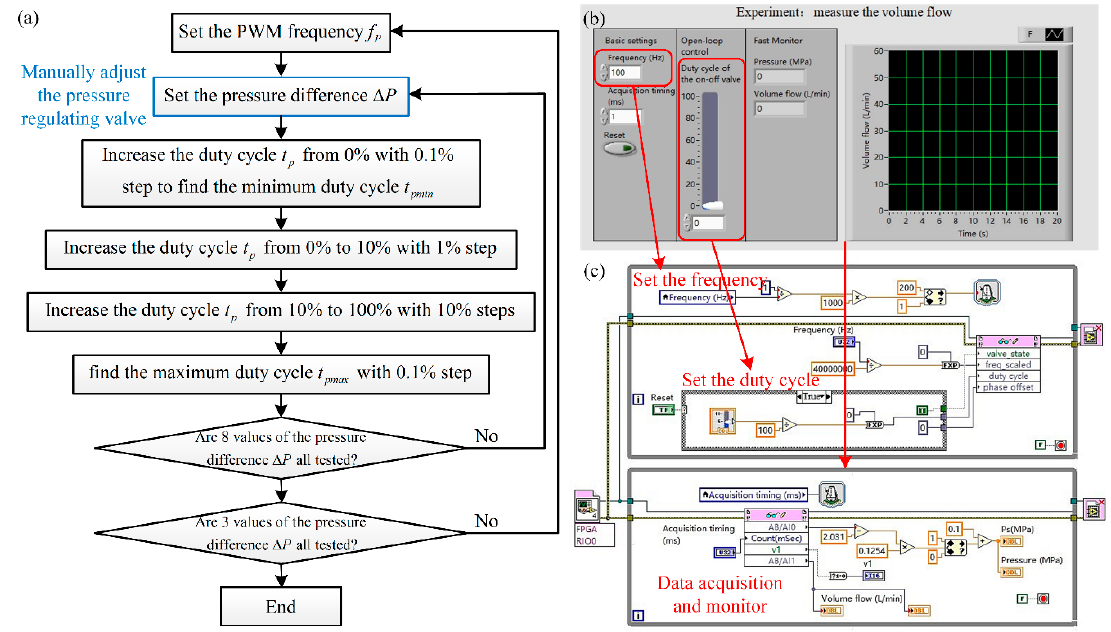
Figure 1. Measure the volume flow: ( a ) Procedure; ( b ) Programming interface; ( c ) Main program. Pulse width modulation (PWM).